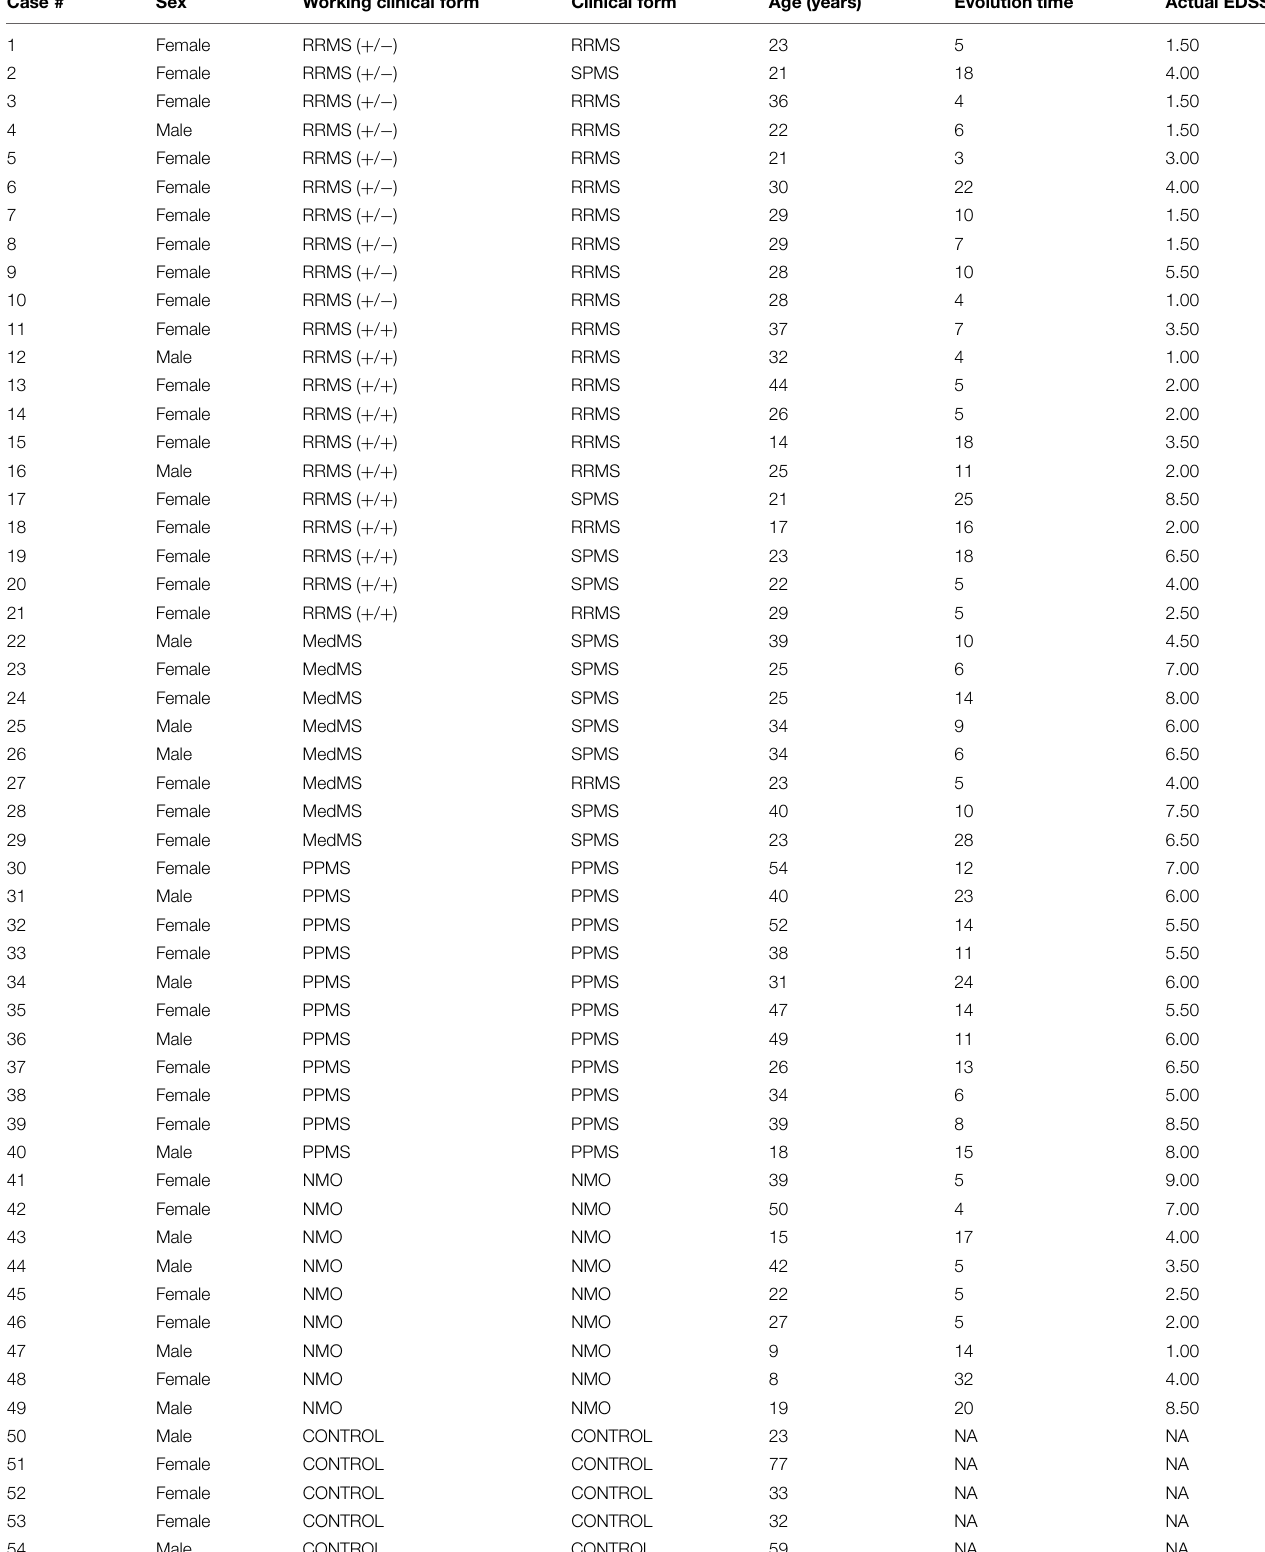
TABLE 1 | Clinical characteristics of the patients